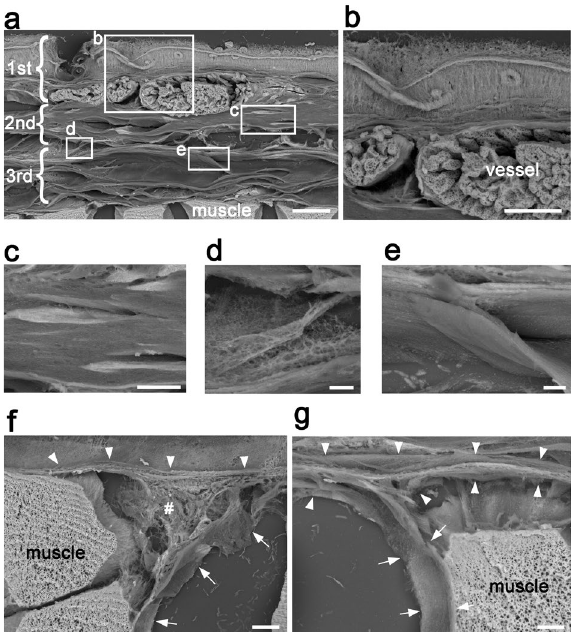
Figure 5. LVSEM of 20-µm sections with hook-holding procedure. ( a ) Image of the deep fascia and rectus femoris muscle of the thick paraffin section from the same block used in Fig. 4b. The deep fascia is separated into three layers from a 3D perspective. Squares in this figure are magnifications of these areas. Scale bar = 30 µm. ( b ) The first superficial layer of the deep fascia is composed of collagen fibers extending in various directions with round vessels repleting abundant erythrocytes. Scale bar = 10 µm. ( c ) The second intermediate layer underneath the first superficial layer is formed of straight and thick bundle. Scale bar = 5 µm. ( d ) The loose connective tissue is identified between the second and the third layer. Extensive networks of extremely thin fibers are noted. Scale bar = 3 µm. ( e ) The third deepest layer is formed by straight and thin collagen fibers. Slight undulation of the surface of the collagen fiber is observed. Scale bar = 3 µm. ( f and g ) The epimysium (arrowhead) is different from the third deepest layer and clearly connects to the perimysium (arrow). Loose connective tissue (#) is identified among the epimysium, the perimysium and the muscle. Scale bar = 10 µm.